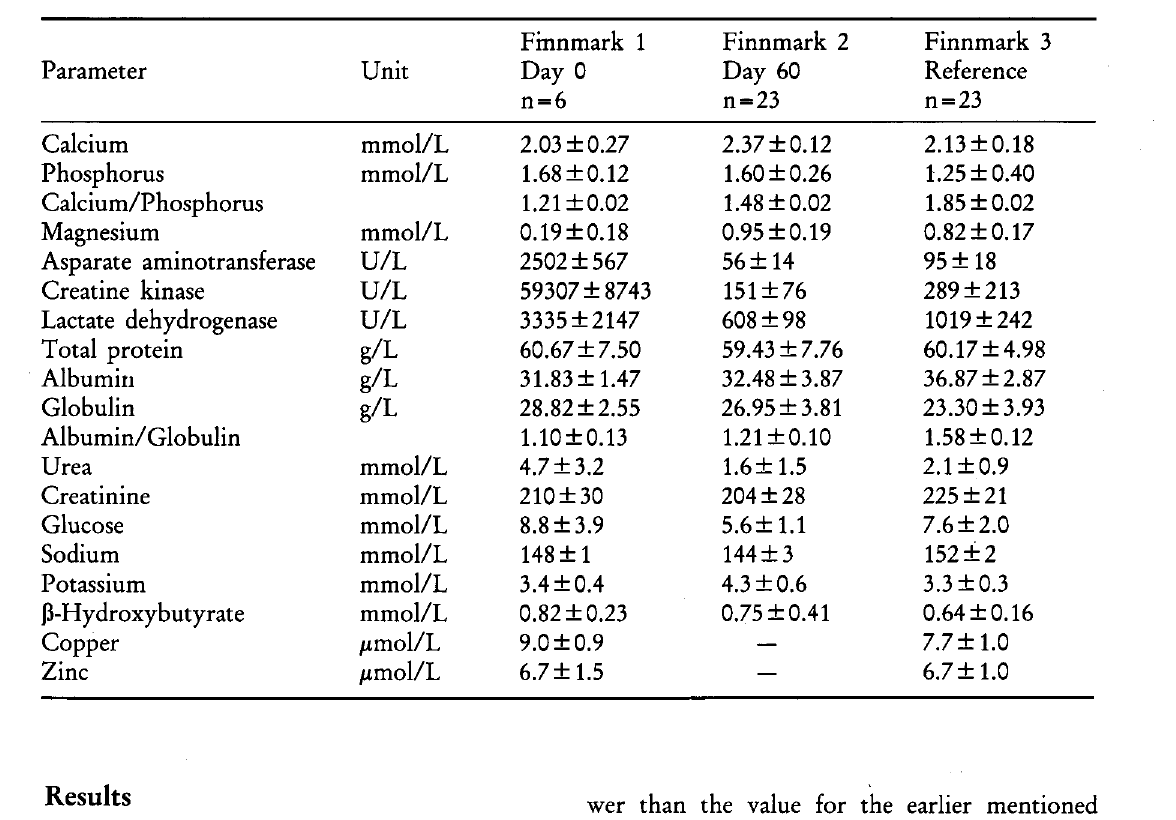
Table 1. Mean and standard deviations on serum biochemistry profile values for adult reindeer. A ll animals were free-grazing reindeer from Finnmark district,